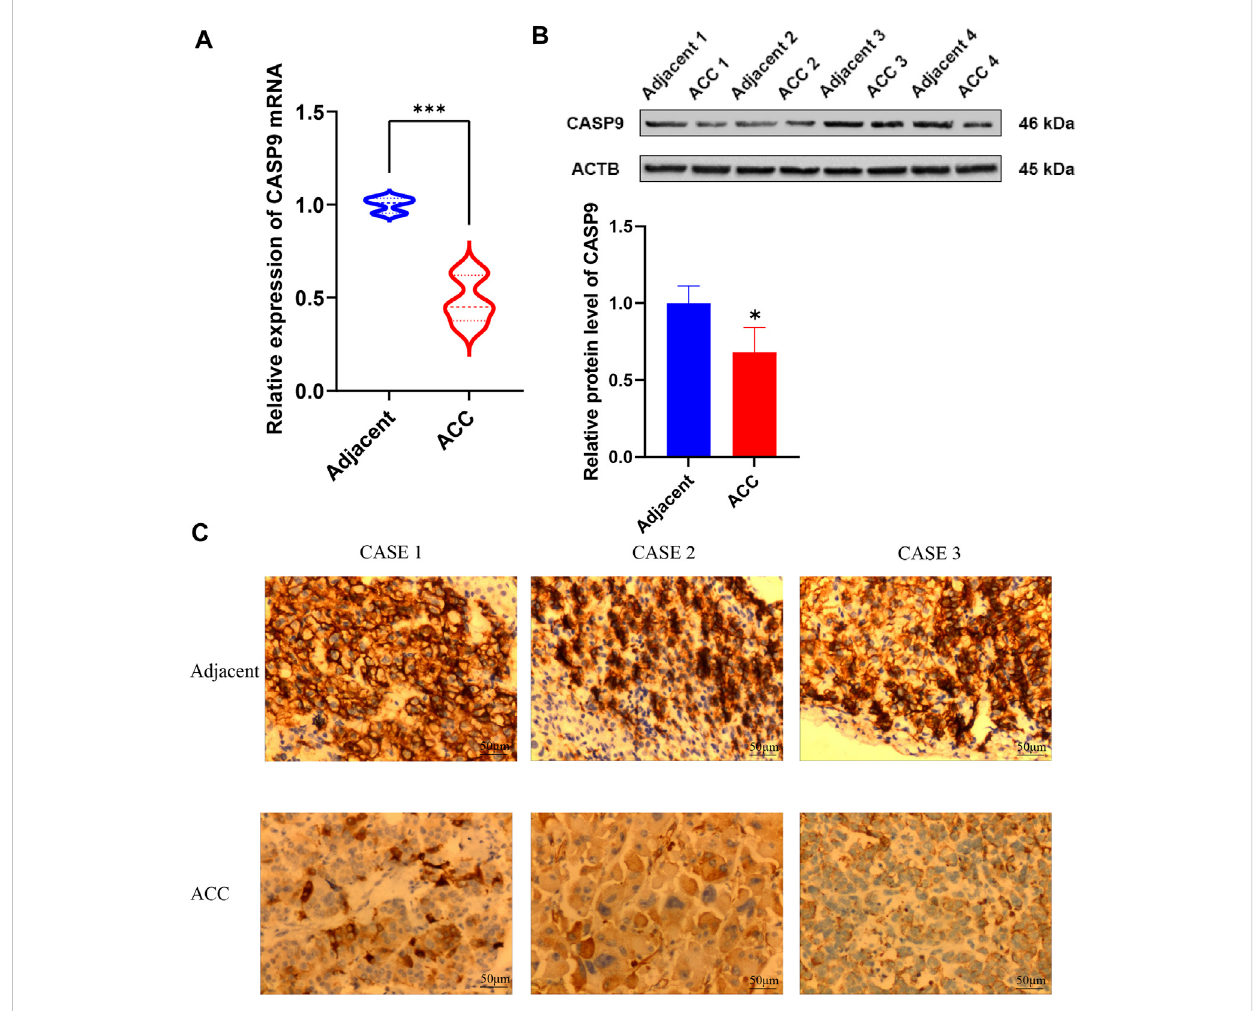
FIGURE 10 Validation of mRNA and protein expression levels of CASP9 in ACC. (A) Comparison of mRNA expression levels of CASP9 by qRT-PCR in 12 paired ACC tissues and adjacent normal tissue samples. (B) The Western blot analyses. (C) The immunohistochemical staining in 12 ACC tissues and adjacent normal